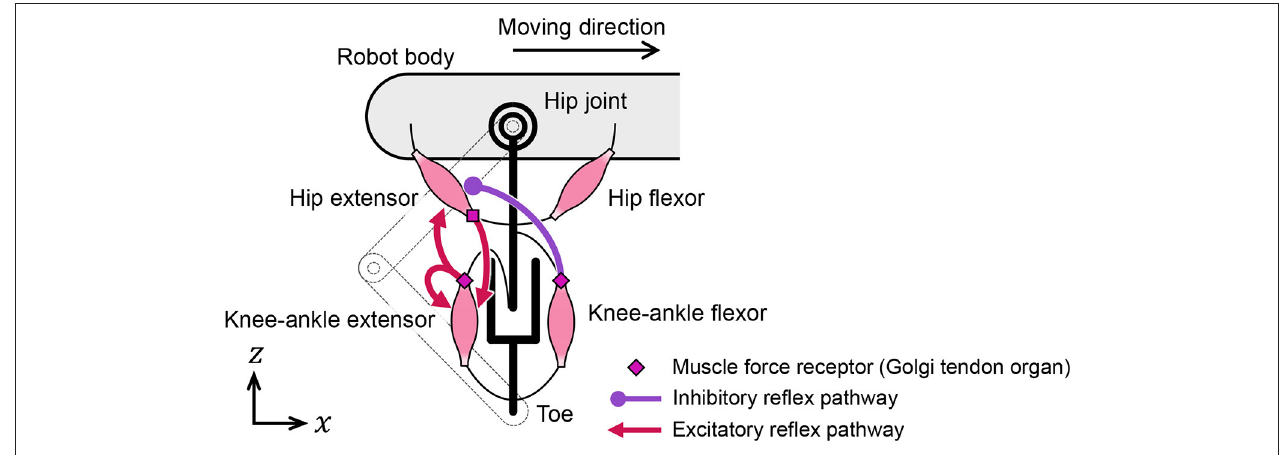
FIGURE 5 | Reflex pathways embedded in the quadruped